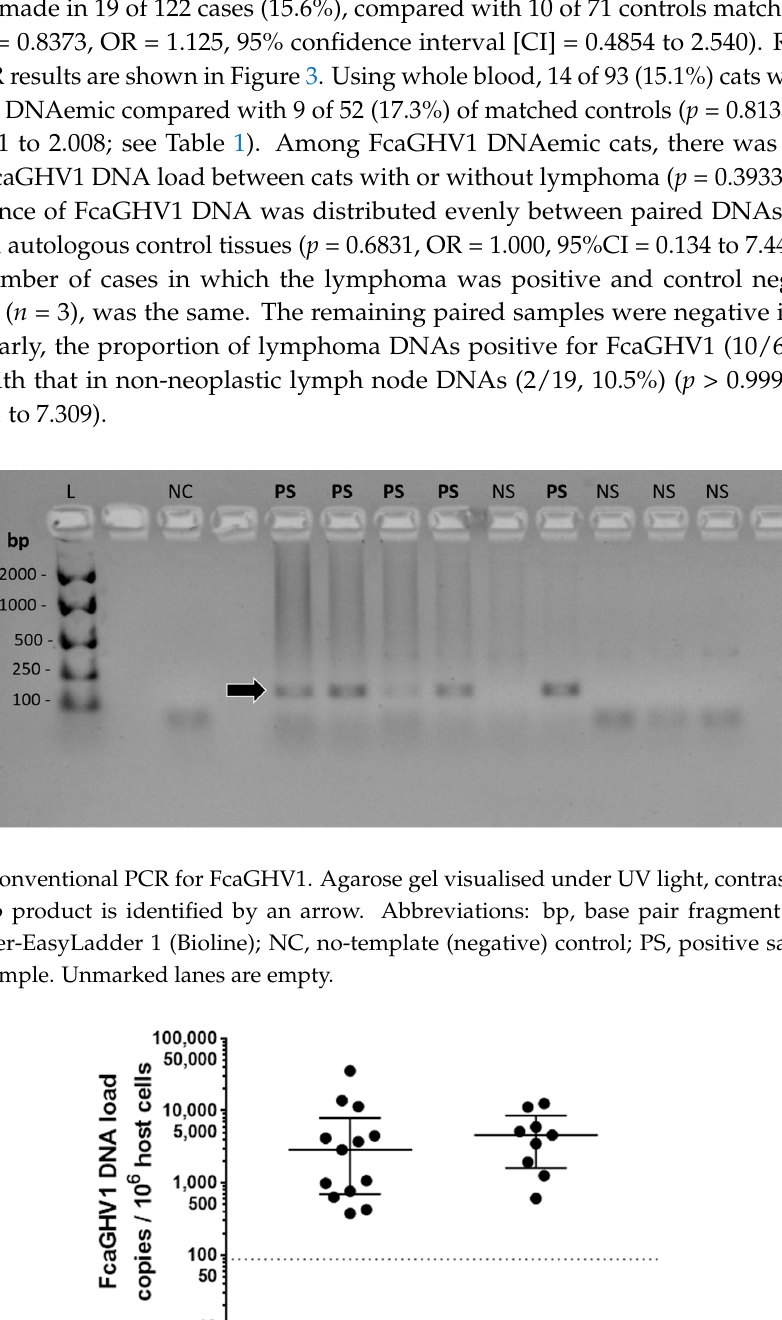
Figure 4. FcaGHV1 whole blood DNA loads in infected lymphoma cases ( n = 13) and controls ( n = 9) ( p = 0.3933). Long bars represent the median and short bars the interquartile range for each group. The dotted line indicates the lowest viral load detected using this qPCR. Table 1. FcaGHV1 positive lymphoma cases and controls by sample type.